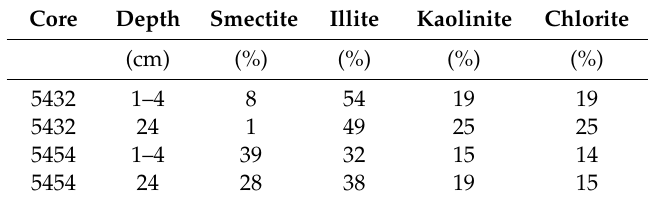
Table 4. Mineral composition of the clay fraction (XRD) in sediment cores of AMK-5432 (the Bear Island Trough), and AMK-5454 (the Cambridge Strait, the Franz Josef Land Archipelago).